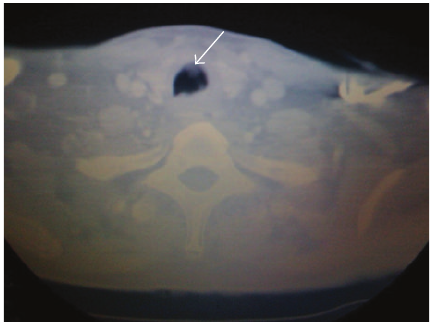
Figure 2: CT scan of the neck showing a haziness in the trachea representing the foreign